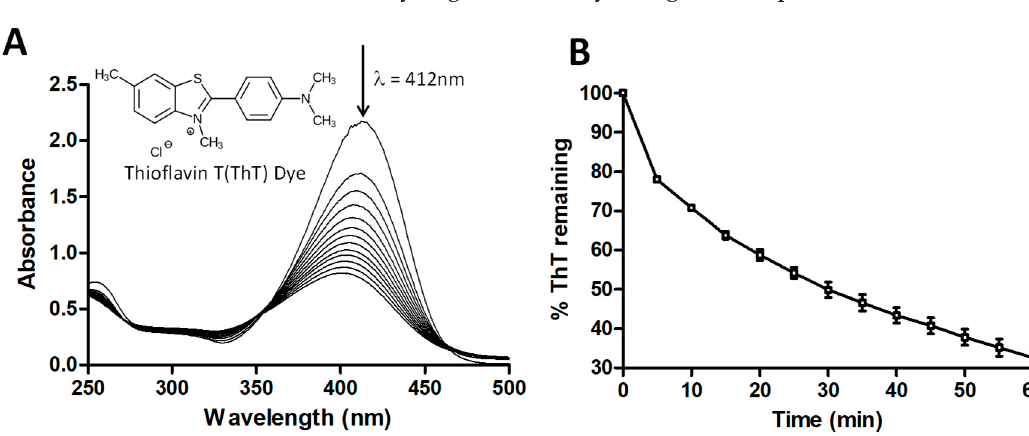
Figure 1. Thioflavin T (ThT) dye degradation by a UV + H 2 O 2 advanced oxidation process. ( A ) ultraviolet/visible (UV/Vis) absorbance spectra for ThT degradation by UV + H 2 O 2 . Concentration of ThT dye = 25 ppm, pH = 2, concentration of H 2 O 2 = 1 mM. The UV/Vis scans were taken every 5 min; ( B ) Percentage of ThT remaining (decrease in absorbance at 412 nm) after treatment with UV + H 2 O 2 . Concentration of ThT dye = 25 ppm, pH = 2, concentration of H 2 O 2 = 1 mM. Data shown is the average of triplicate measurements (± standard deviation (SD)).